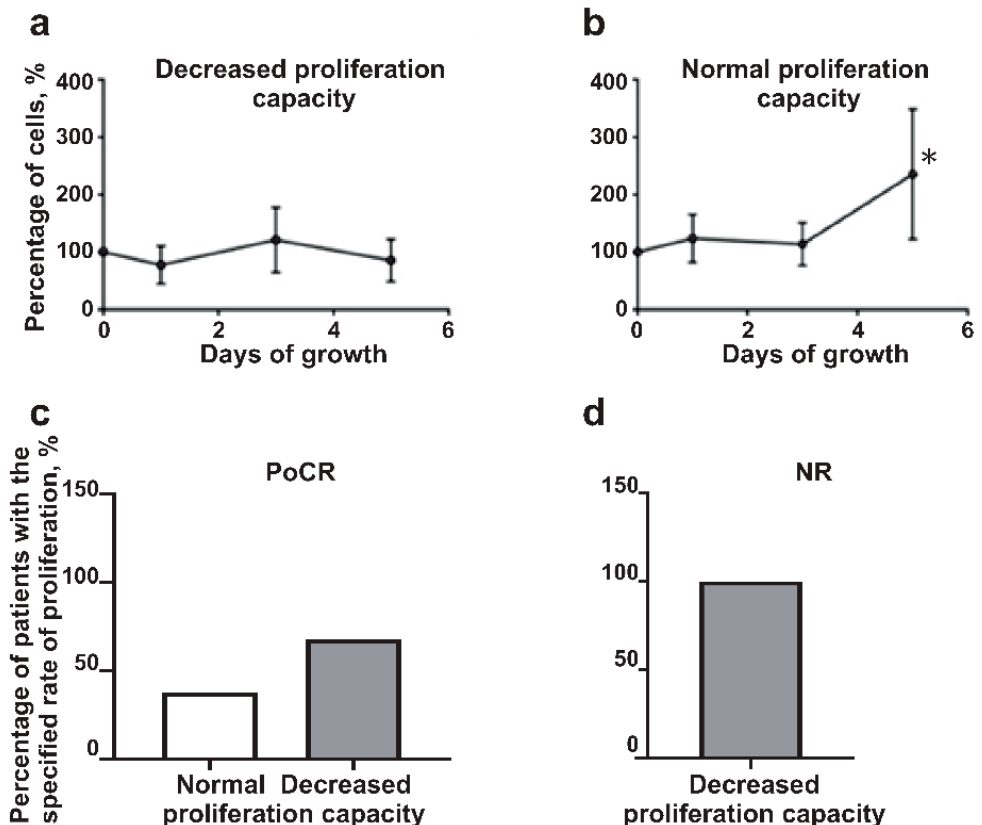
Figure 3. The proliferation rate of MM-MSC and HD-MSC. MSC cultures from patients were divided into groups with decreased ( a ) and normal proliferation capacity ( b ); ( c ) part of PoCR patients’ MSC cultures had normal proliferation rate (white column) while the majority of samples had decreased proliferation capacity (grey column); ( d ) all of NR proliferated at a slower rate (similar to the rate shown in ( a ). Abbreviations: NR = non-responders, patients with ineffective treatment; PoCR = partial or complete response, MSC = mesenchymal stem cells, HD-MSC = mesenchymal stem cells of healthy donors; MM-MSC = mesenchymal stem cells from bone marrow of patients with multiple myeloma. * p < 0.05.